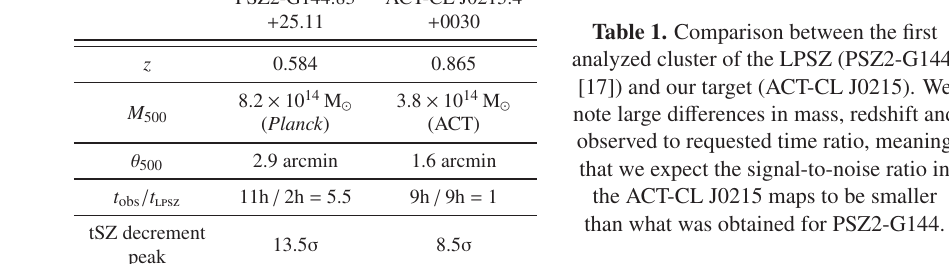
Table 1. Comparison between the first analyzed cluster of the LPSZ (PSZ2-G144, [17]) and our target (ACT-CL J0215). We note large di ff erences in mass, redshift and observed to requested time ratio, meaning that we expect the signal-to-noise ratio in the ACT-CL J0215 maps to be smaller than what was obtained for PSZ2-G144.